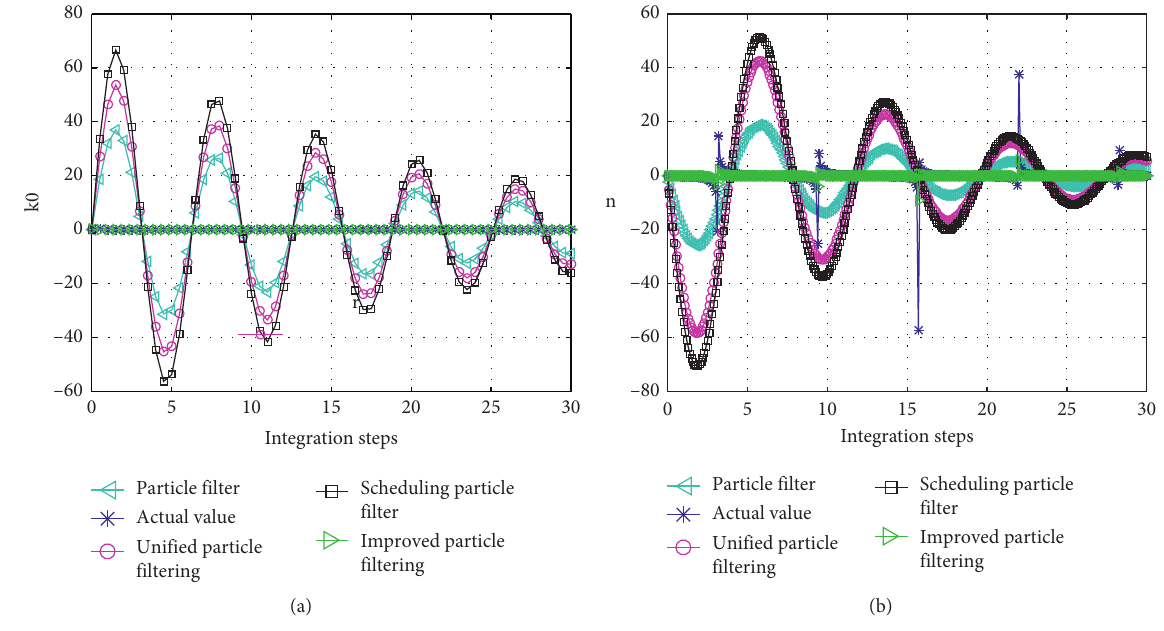
Figure 4: English speech rationality optimization keyword recognition value. (a) k0. (b) n